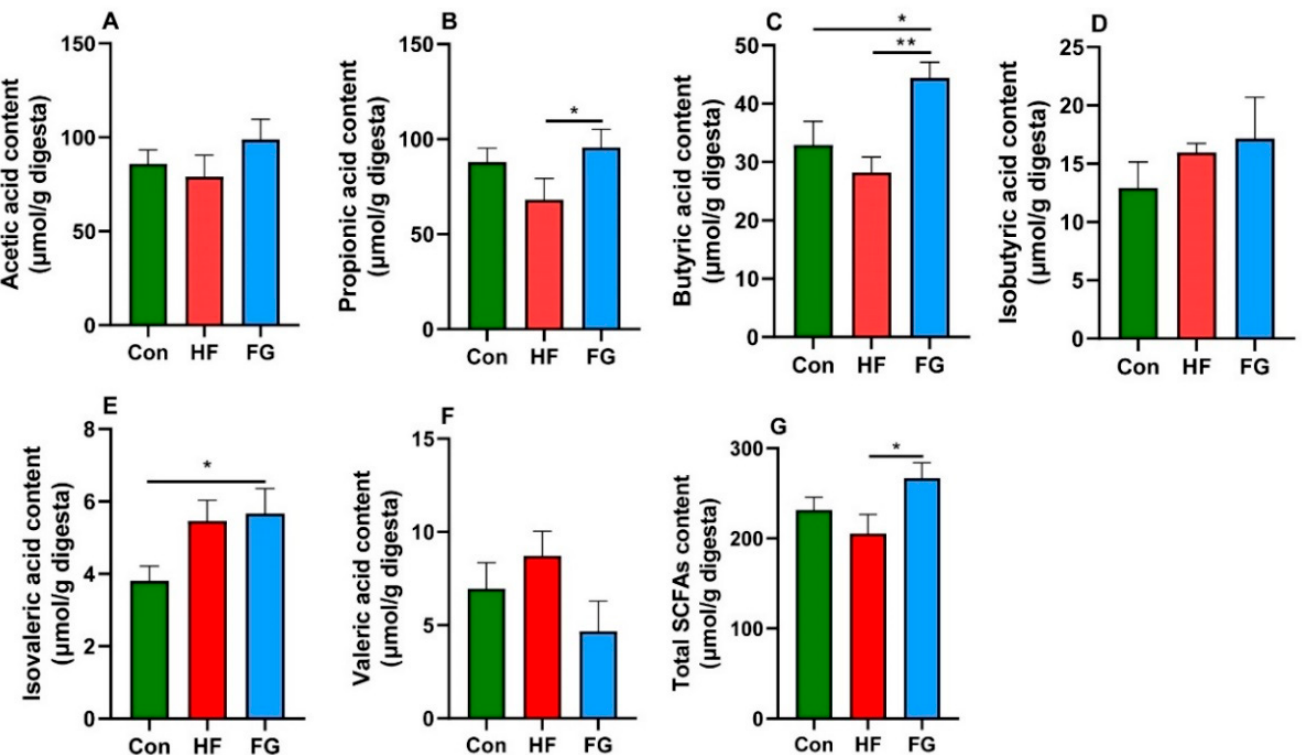
Figure 6. Effects of dietary fat level and GABA supplementation on the cecal concentrations of acetic acid ( A ), propionic acid ( B ), butyric acid ( C ), isobutyric acid ( D ), isovaleric acid ( E ), valeric acid ( F ), and total SCFAs ( G ). Data are presented as mean ± SEM, * p < 0.05, ** p < 0.01. SCFAs, short-chain fatty acids.